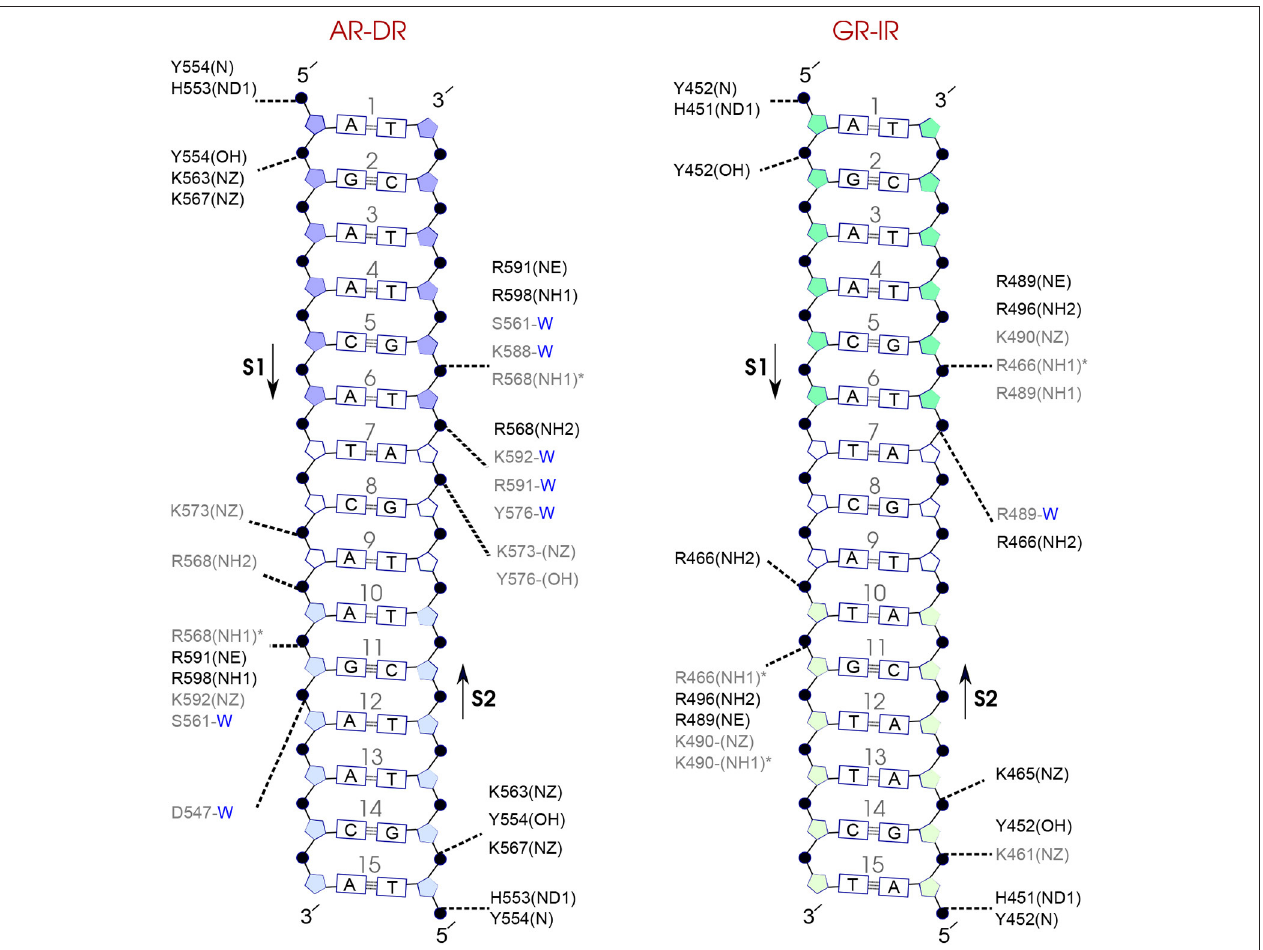
FIGURE 7 | Diagram of protein-DNA hydrogen-bond interactions for (left) AR-DR and (right) GR-IR. The nucleotides of the 15 bps core DNA sequence are numbered from HS1 (numbers: 1–6) to HS2 (numbers: 10–15). The spacer region is highlighted with non-colored boxes around the numbers of the bases (numbers: 7–9). The hydrogen bonds are categorized based on their occupancy, 50–75% (gray), and 75–100% (black). The water mediated hydrogen bonds are shown with a blue letter “W.” The residues shown with star sign form base-specific hydrogen-bond interactions while the other residues interact with the backbone of the